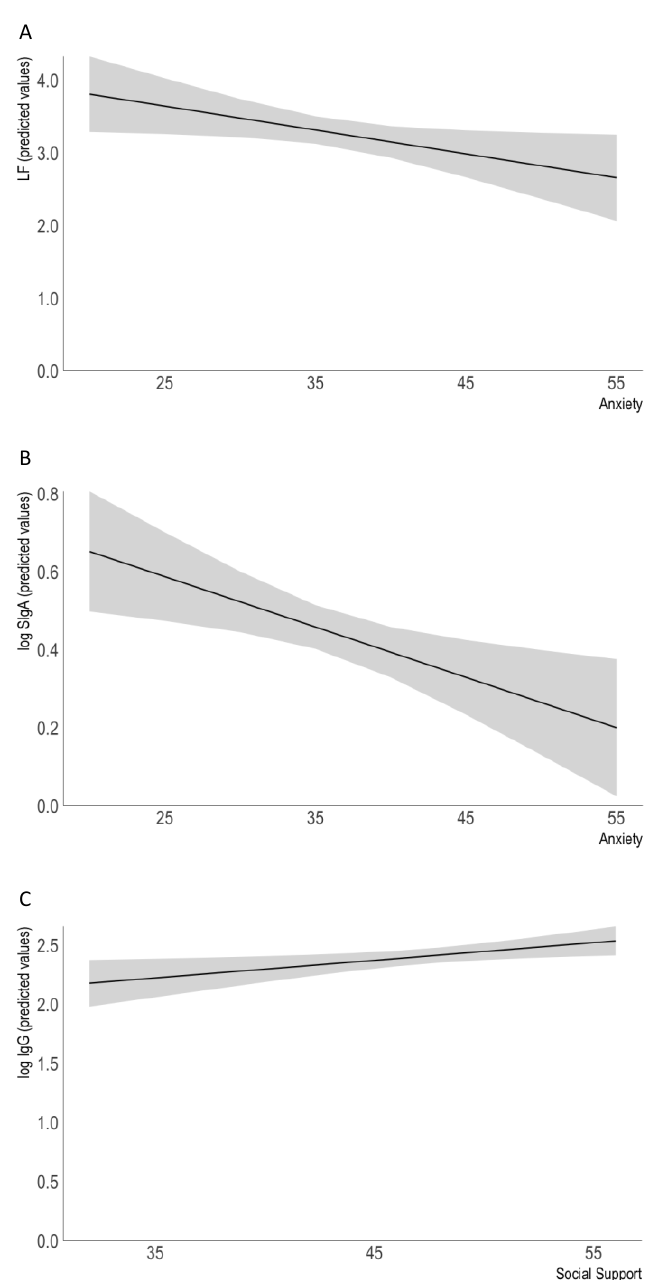
Figure 1. The association between maternal state of anxiety and social support, and the predicted level of immunoactive components in human milk (estimated marginal means, adjusted for the means of other variables in the models). A negative association was found between the level of lactoferrin ( A ) and SIgA ( B ) and maternal anxiety. A positive association was found for the level of IgG and social support ( C ).